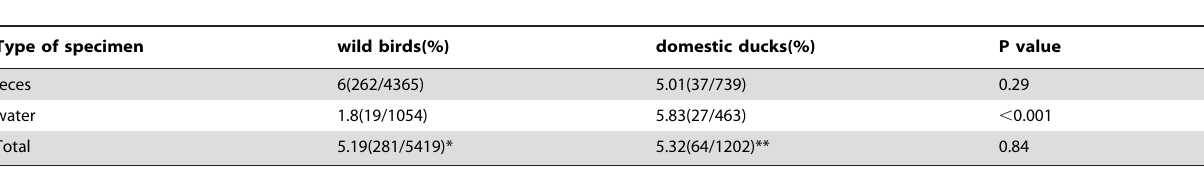
Table 2. Prevalence of AIV in samples collected from wild birds and domestic ducks.